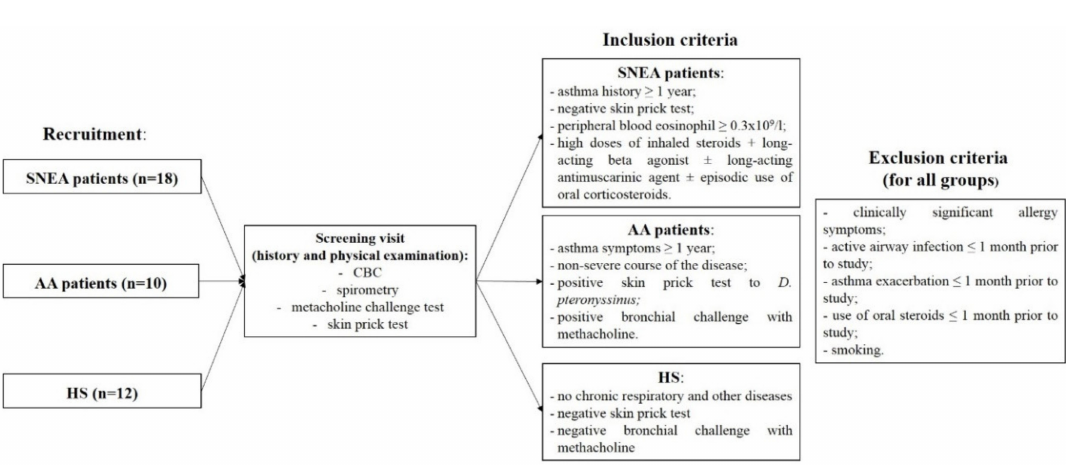
Figure 1. Inclusion and exclusion criteria of the study population. All recruited individuals were newly selected subjects. The inclusion and exclusion were criteria were verified after the screening